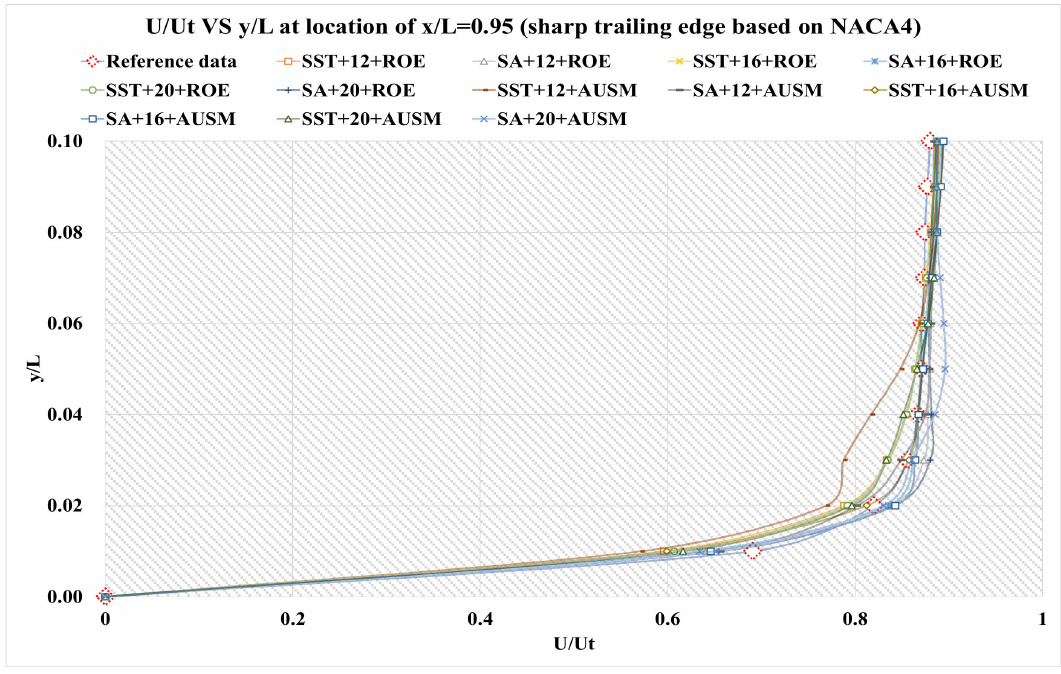
Figure 9. Distributions of U/U t of the sharp trailing edge based on NACA4 at location of x/L =